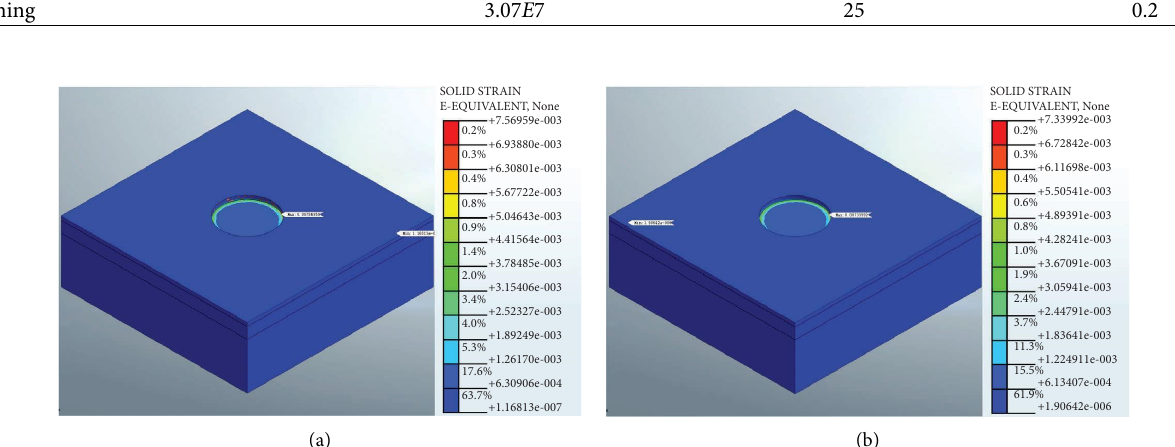
Figure 11: Working condition 2. Equivalent soil strain (a) without pore water pressure and (b) with pore water pressure applied.